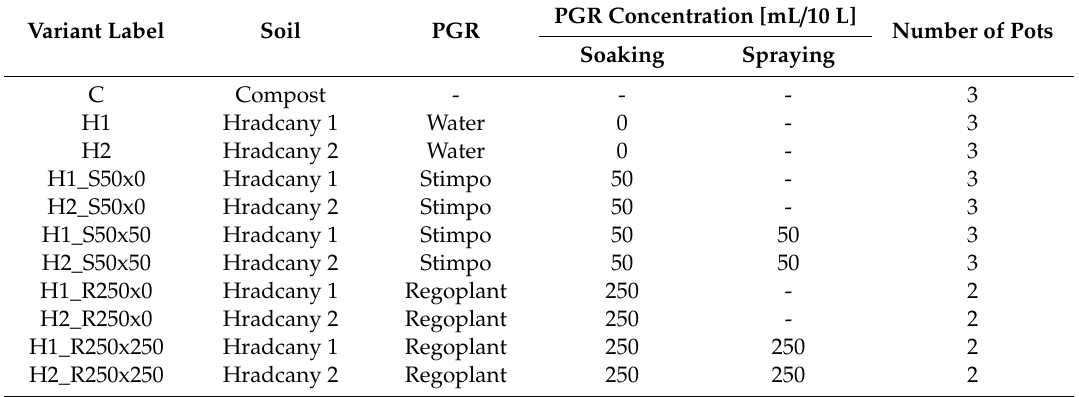
Table 3. Experiment